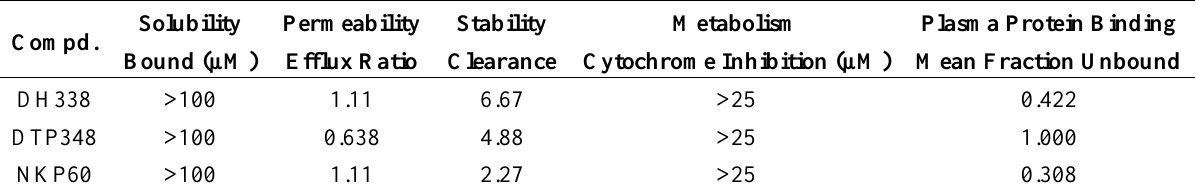
Table 1. Pharmacokinetics data for compounds